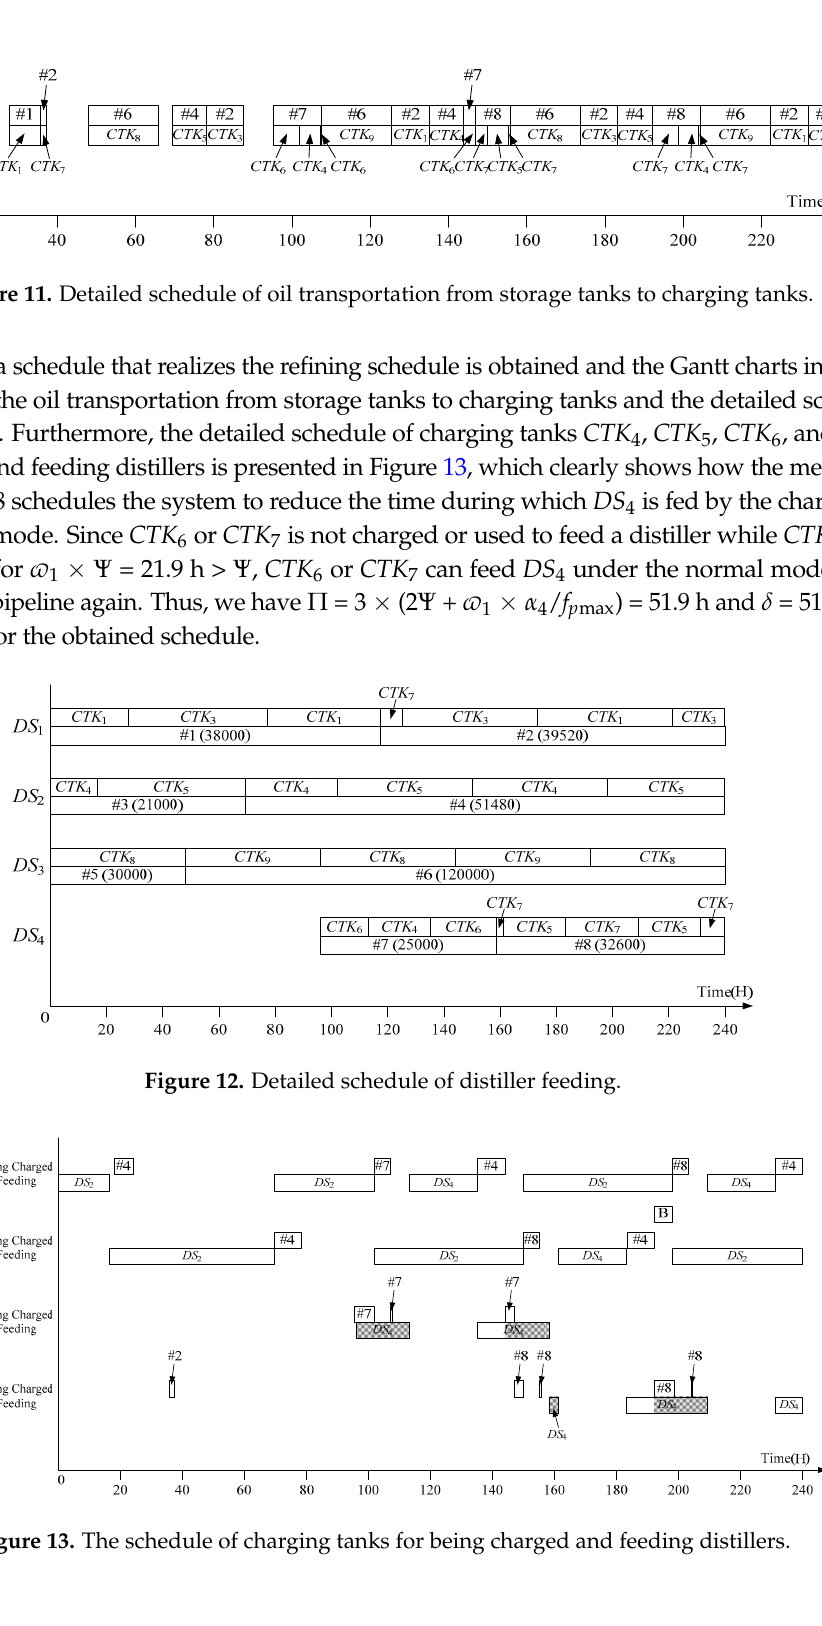
18 of 25 Table 1. Initial state for the charging tanks. Tank